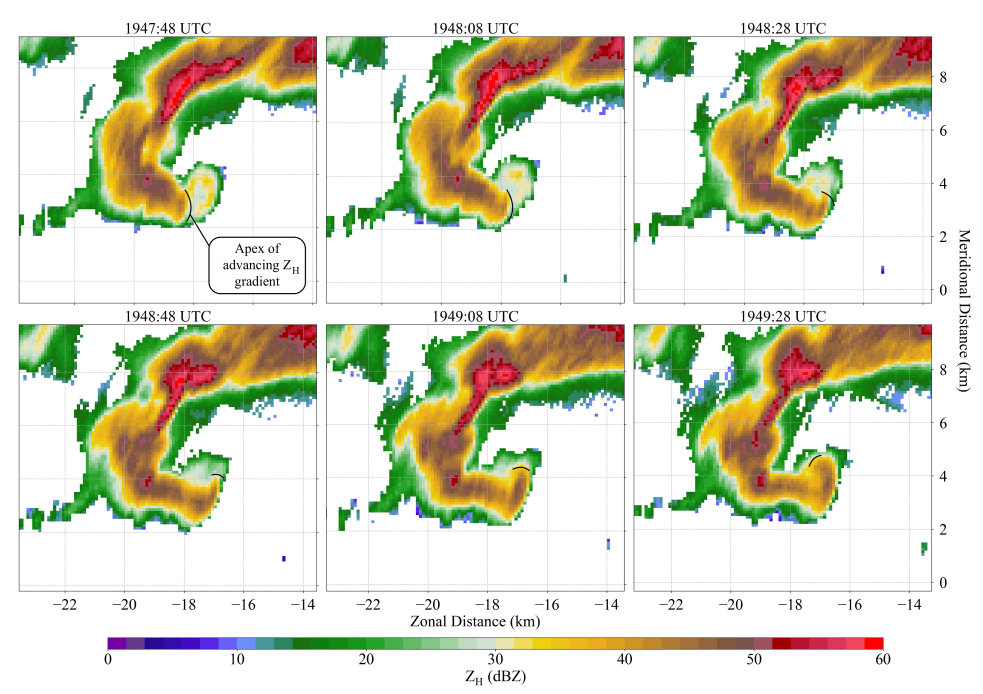
Figure 8. Six consecutive radar scans from PX-1000 of Z H every 20 s from 1947:48 to 1949:28 UTC highlighting the advancing Z H gradient during surge A.